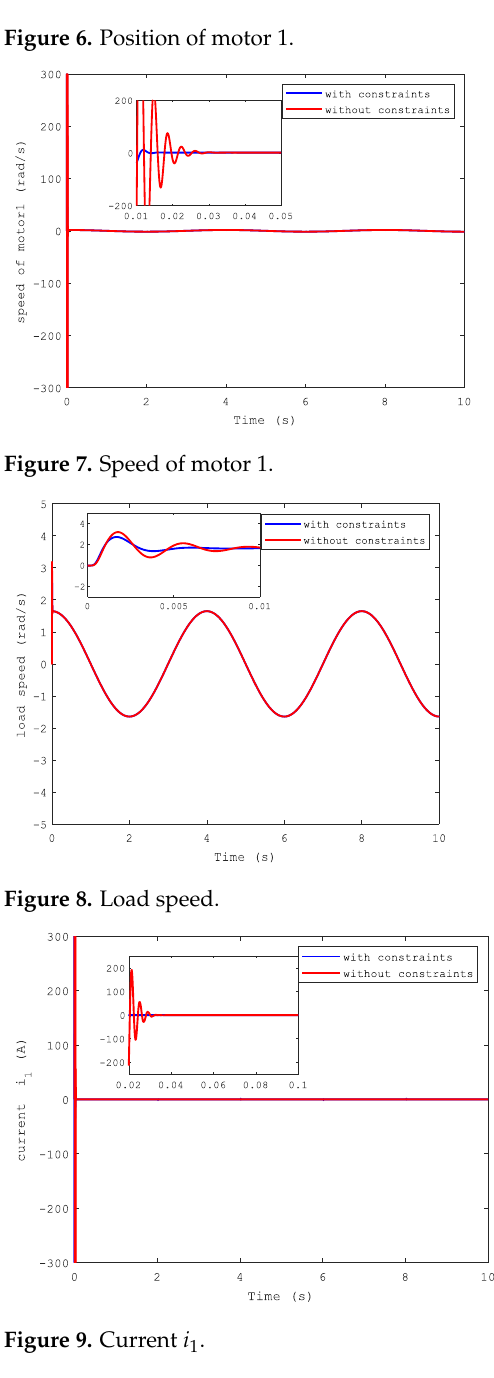
Figure 9. Current . Figure 9. Current .